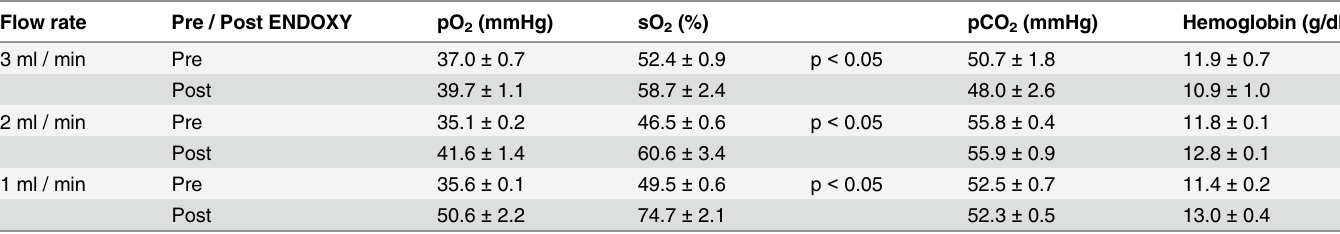
Table 7. Gas transfer measurement of coated Lumox ™ slide after redesign — blood gas analysis. Flow rate